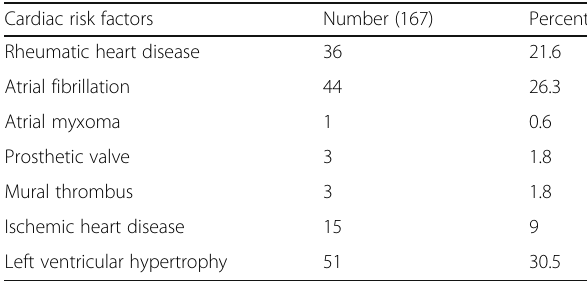
Table 3 Results of cardiological assessment in 167 ischemic stroke patients